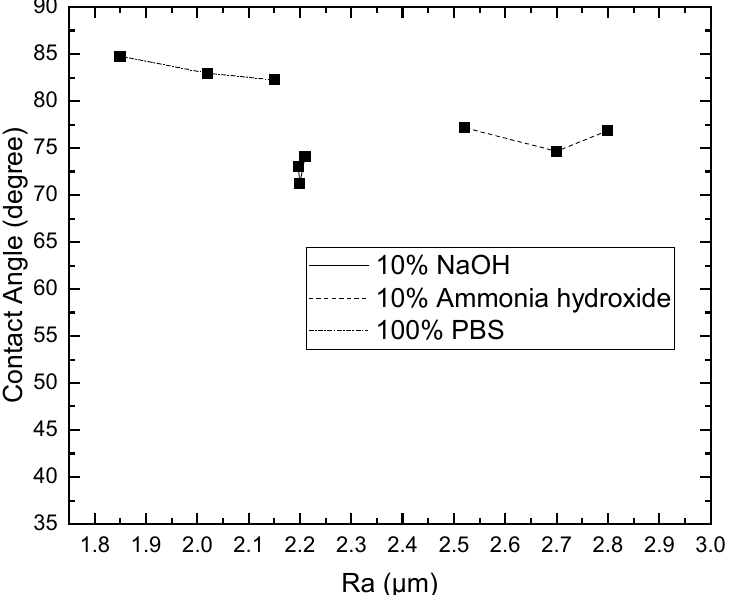
Figure 11. Contact angles of distilled water on Parylene C coated on a substrate with a Shore A hardness of 95 soaked in different solutions.